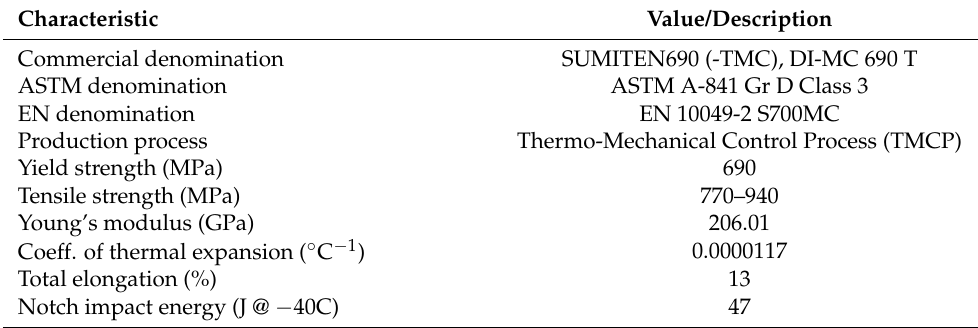
Table 1. Characteristics of the selected steel for the renovation of the lining in Chivor II.